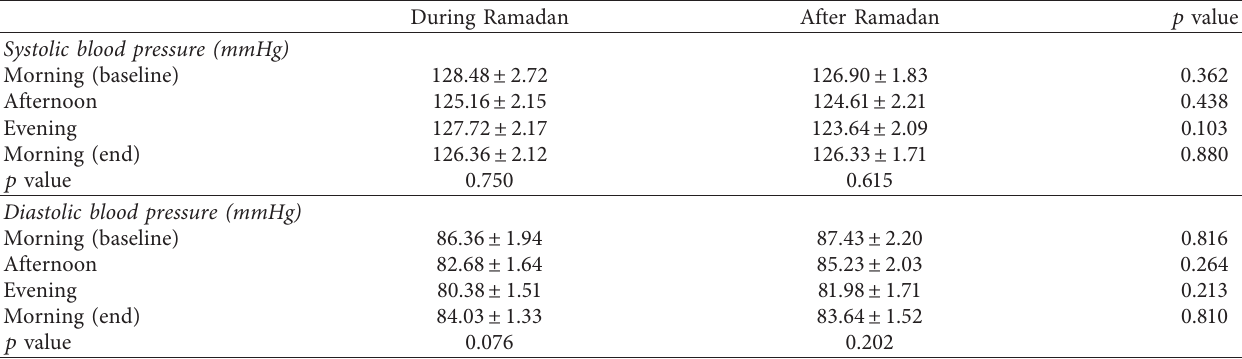
Table 4: Blood pressure variation in fasting and nonfasting